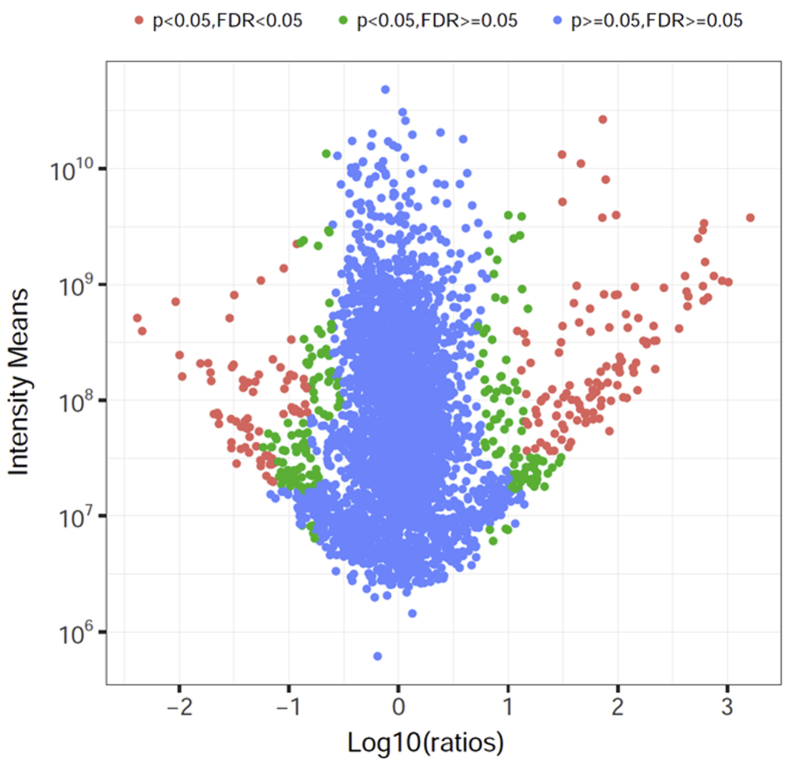
Proteome-wide quantification and significant fold change in well-differentiated normal human primary bronchial/tracheal epithelial cells compared with un-differentiated cells. Each dot represents a protein. The X-axis is the Log10 ratio obtained by dividing the mean of each protein's value in well-differentiated normal human primary bronchial/tracheal epithelial cells by its value in un-differentiated cells. FDR = false discovery rate.